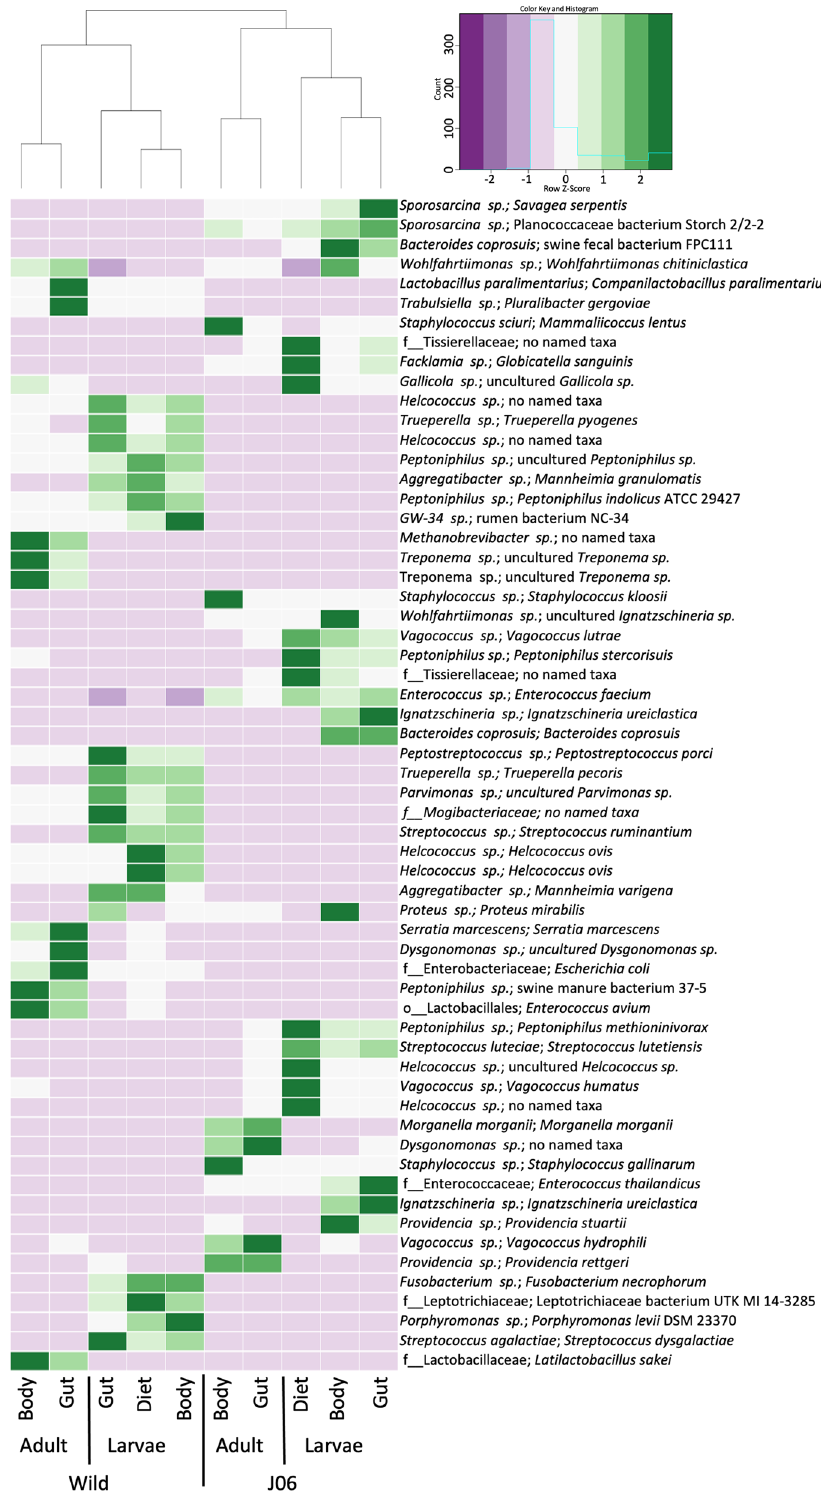
Figure 6. A heatmap showing the relative quantity of the top 20 most abundant ASVs per sample type. After removing duplicates, 60 unique ASVs remained. Purple represents lower abundance, while dark green is higher. The taxonomic classifications for each ASV are shown to the right side of each row, with the Greengenes classification first and the NCBI BLAST result second following the “;”. The dendrogram above the heatmap shows relative similarity based on these 60